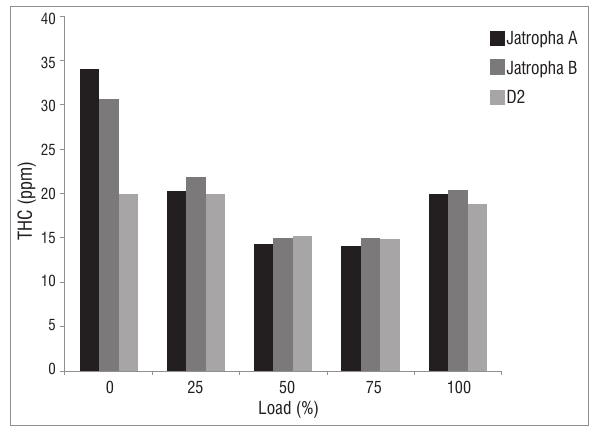
Figure 3: Total hydrocarbon (THC) emissions for the different fuel samples at different loads.